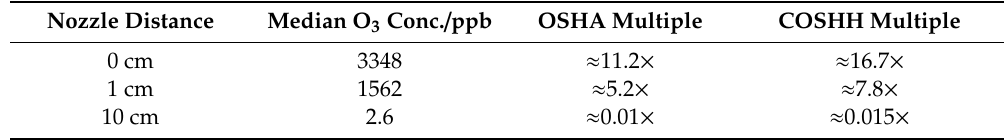
Table 1. Ozone concentration during application of the plasma comb measured in three different